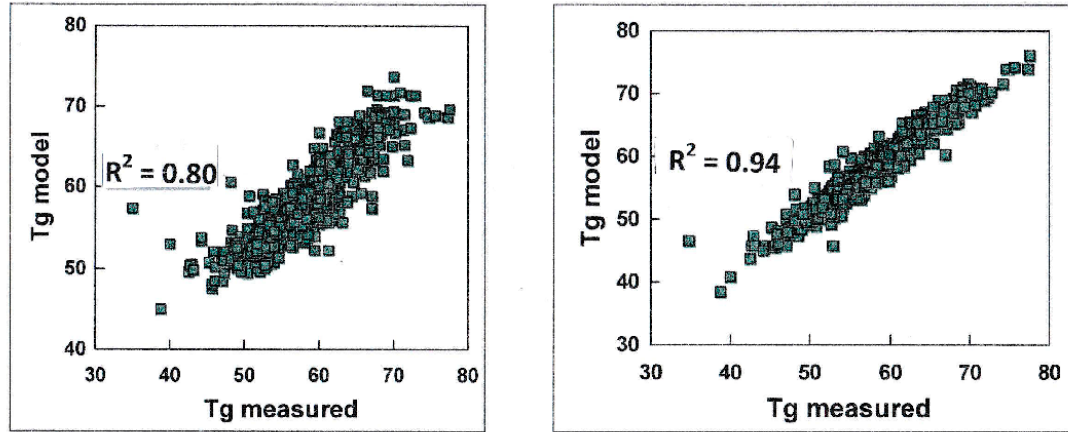
Figure 2. Neural network based methods for the glass transition temperature Tg for a series of polymers. Different models were built leading to different quality with R 2 ranging from 0.80 to 0.99. It can be seen clearly that for R 2 < 0.99 the model does not describe all Tg values within a few degrees.